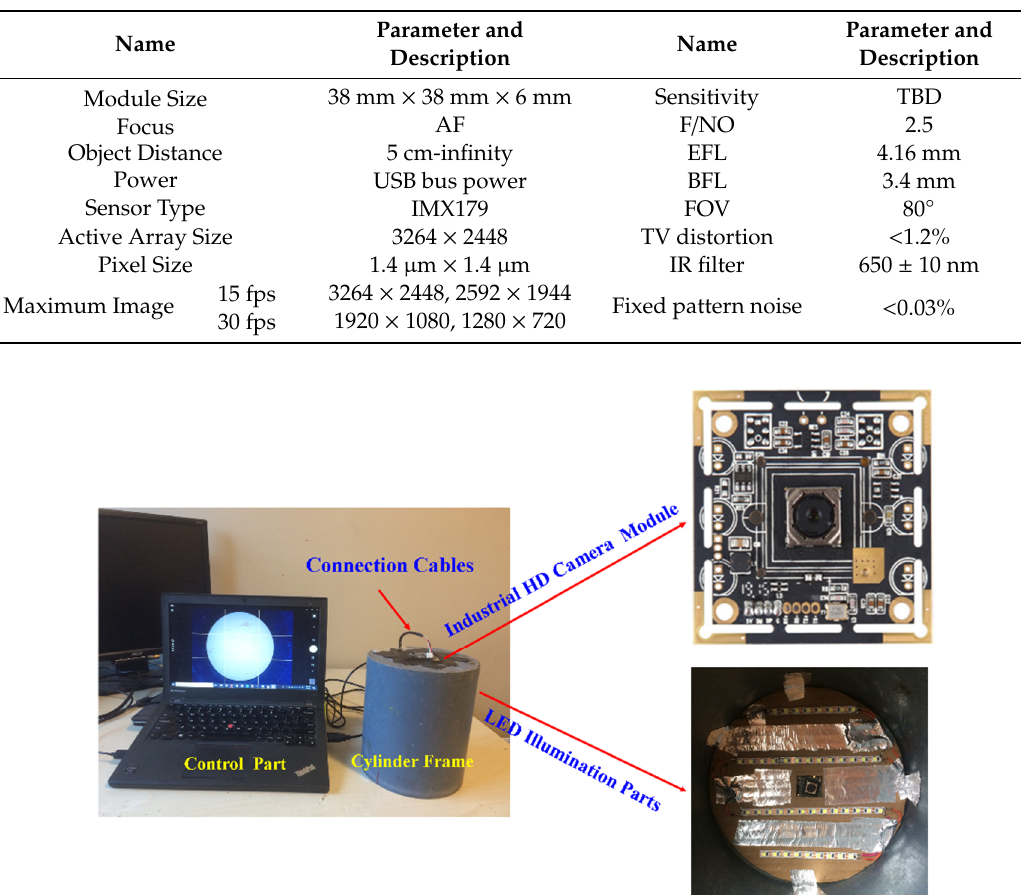
Table 1. Parameters of Industrial HD camera module.